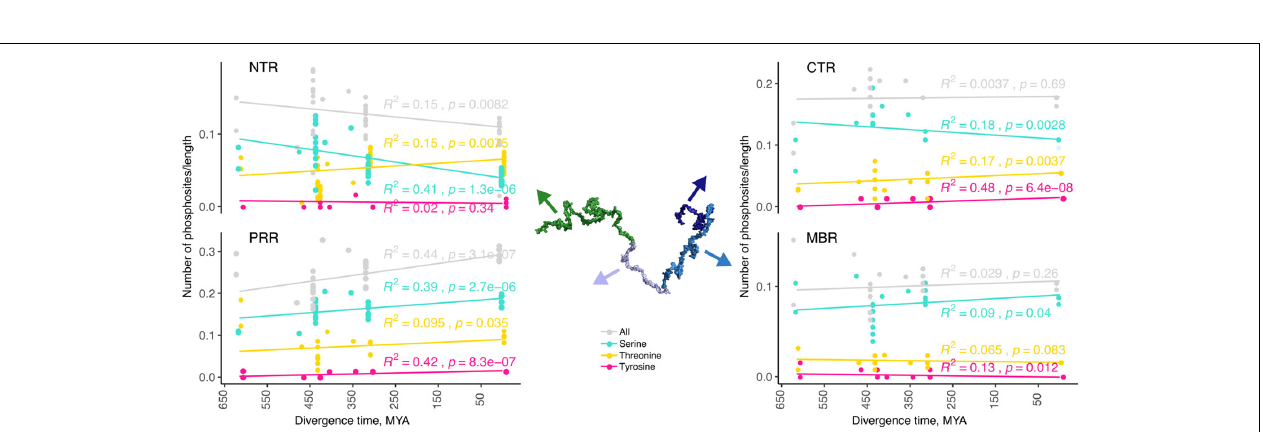
FIGURE 3 | The number of predicted phosphorylation sites changes during evolution in a region-specific manner. Predicted phosphorylation sites for the different regions of tau (NTR, PRR, MBR and CTR) are shown. The numbers of predicted sites were normalized by the length of the analyzed regions. Selected species were grouped by divergence times between mammals and other groups of vertebrates. Coefficients of determination and p -values for the linear regression model are presented near the line fits. Fits with p -values higher than 0.05 are considered to show no significant relationship between divergence times and normalized numbers of predicted phosphorylation sites. Note, that the PRR is the only region where overall phosphorylation increases during evolution.